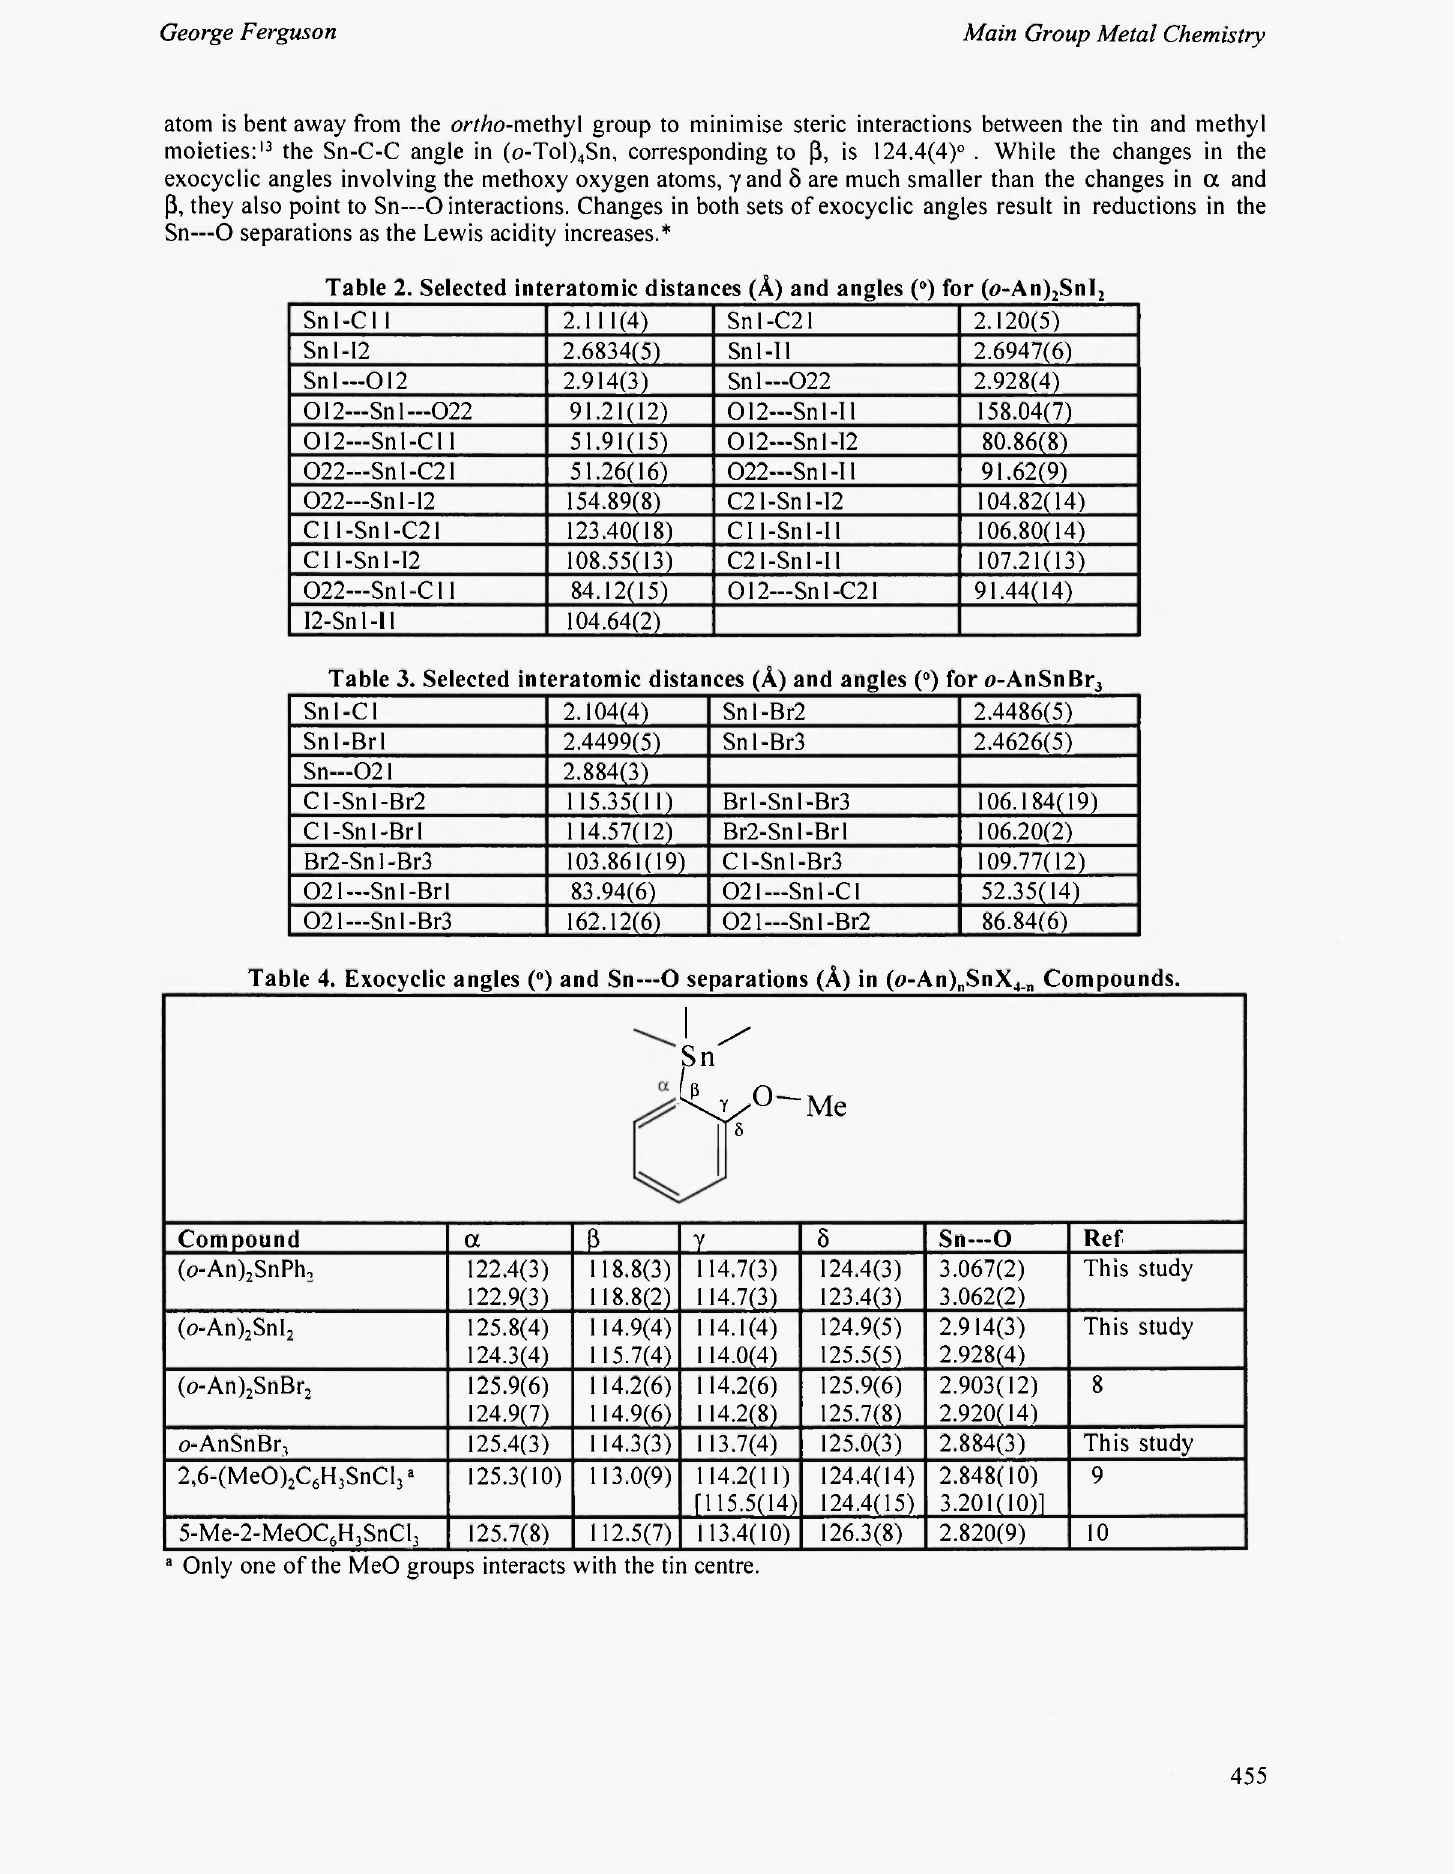
Table 3. Selected interatomic distances (Ä) and angles (°) for o-AnSnBr 3